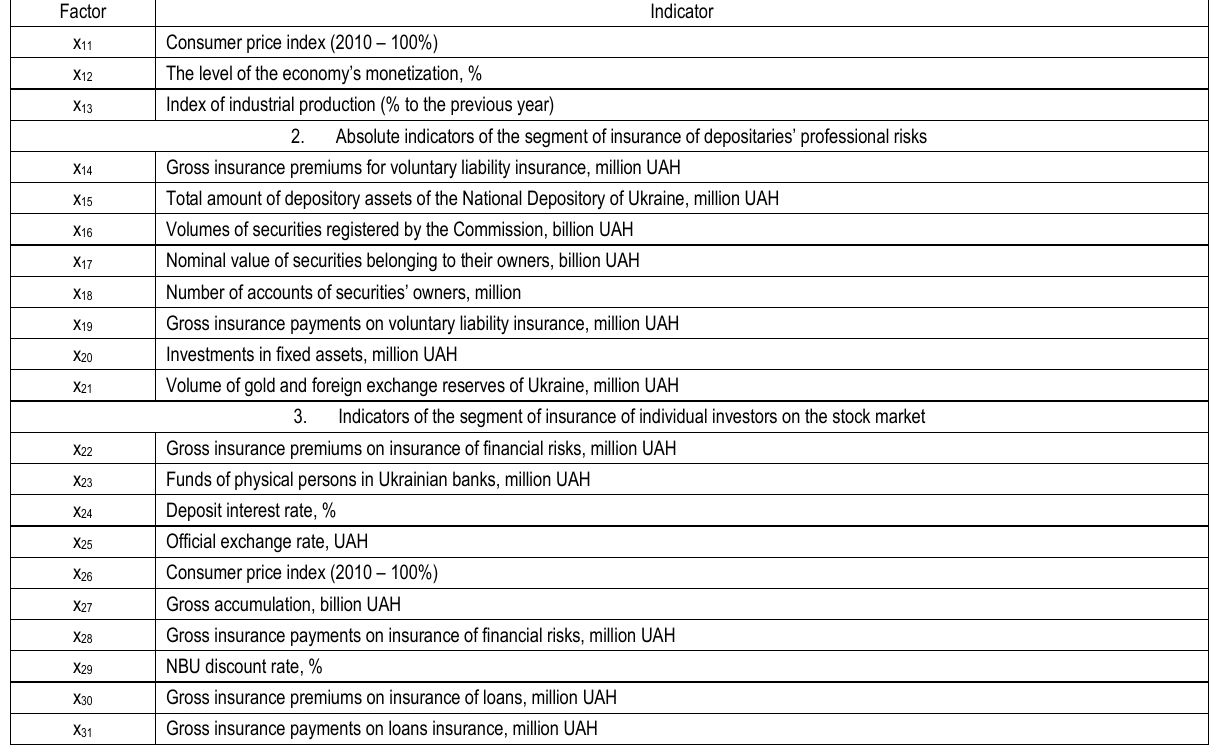
Table 1 (cont.). Absolute indicators of the development of the stock and insurance markets, as well as the Ukrainian economy as a whole by